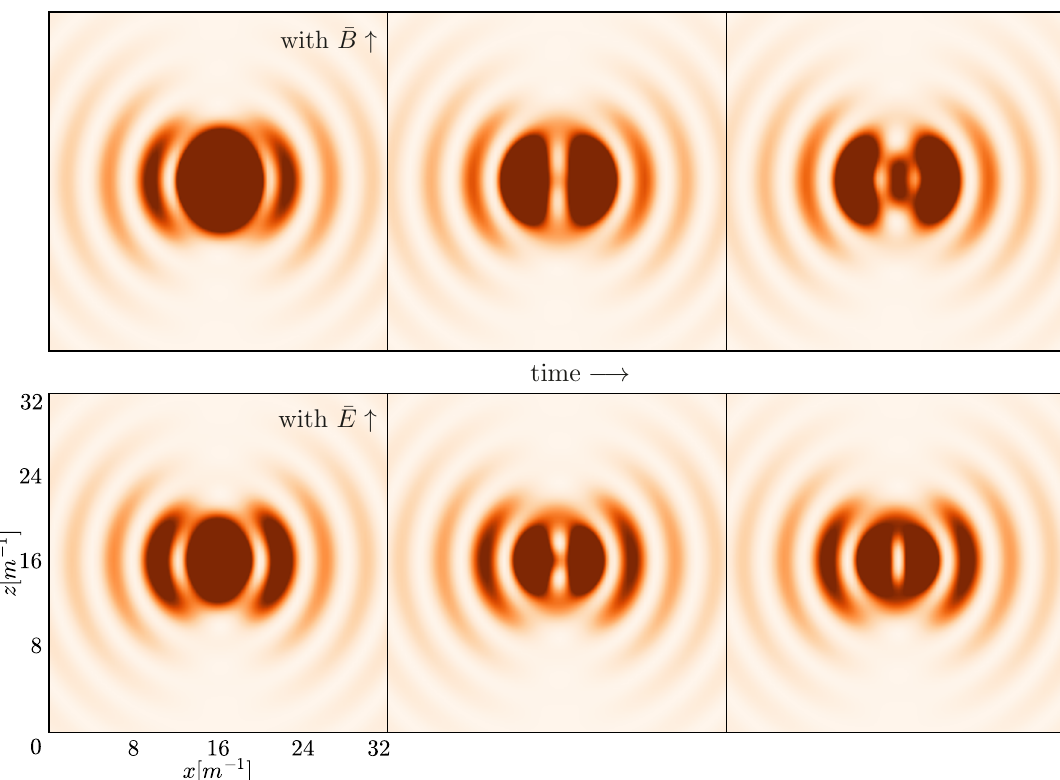
Figure 3 . (Top panels) Energy density of the emitted electromagnetic radiation from an oscillating electric dipole created by an axion star at rest in a background magnetic field. (Bottom panels) Dipole radiation from an oscillating magnetic dipole created by an axion star at rest in a background electric field. The magnetic and electric fields point in the z direction. The colors represent electromagnetic energy density (cid:15) = (1 / 2)( E 2 + B 2 ) after subtracting the background fields. Darker γ colors represent higher energy densities. For visual clarity, we have allowed for colors to be saturated in the densest